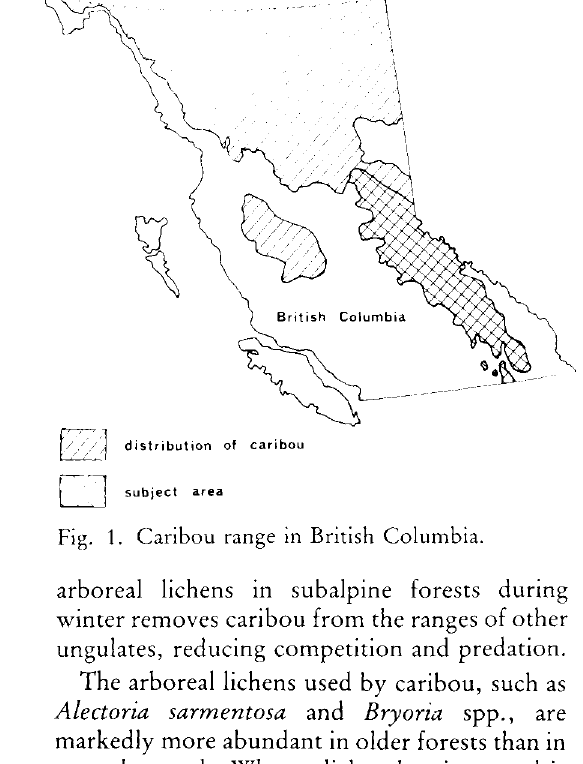
Fig. 1. Caribou range in British